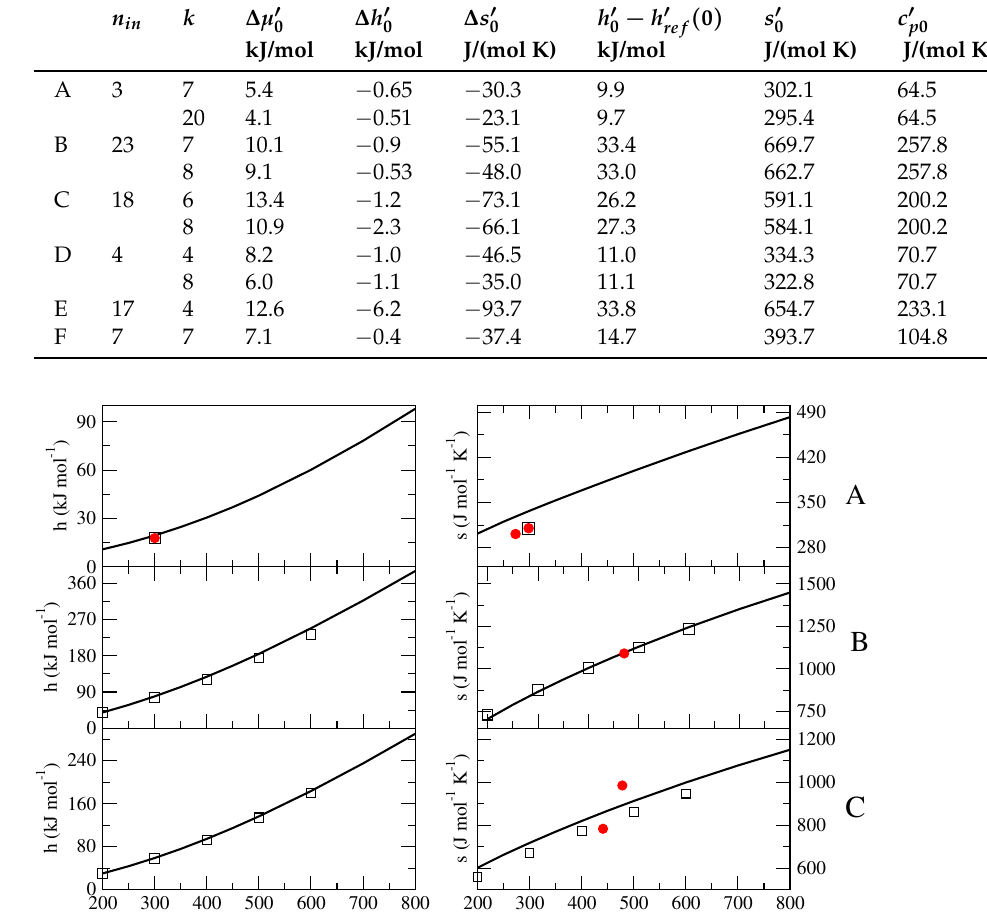
Figure 4. Standard-state molecular full enthalpy (with respect to h ref ( 0 ) ) and entropy as a function of the temperature for n-butane ( A ), BmimNTf 2 ( B ) and BmimPF 6 ( C ), as provided by our equation of state (solid line). The available experimental data found in the literature are reported with filled red circles: for ( A ) from references [31,32]; for ( B ) from references [34,36,53]; for ( C ) from references [35,54]. Values calculated with different theoretical-computational procedures are reported with squares: for ( A ) from reference [17]; for ( B ) from reference [36]; for ( C ) from reference